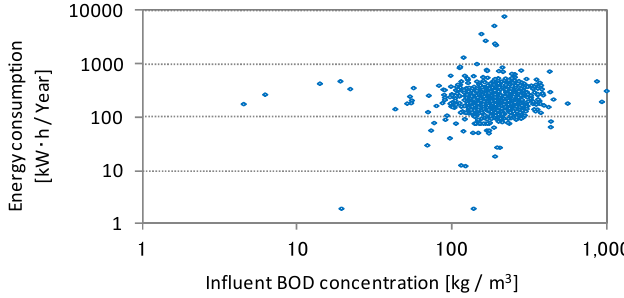
Figure 14. Relationship between energy consumptions and influent BOD concentrations for sewerage treatment facilities.